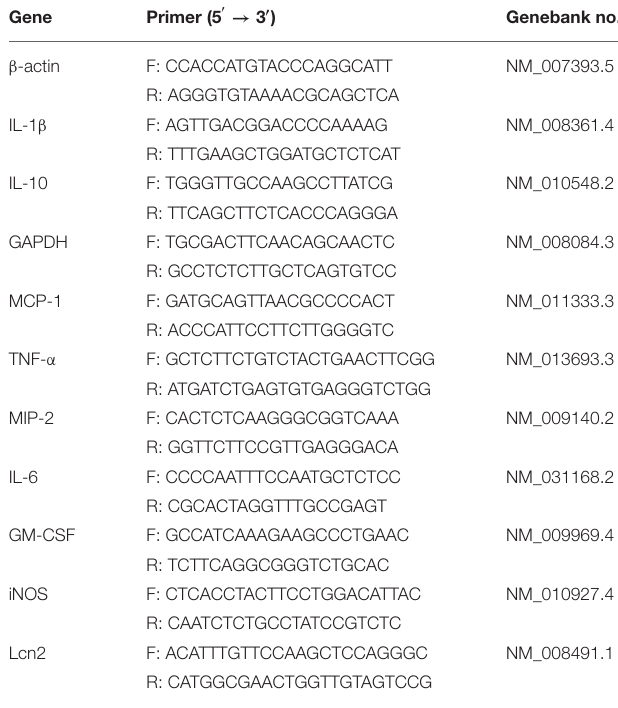
TABLE 1 | Primer sequences for the real-time PCR